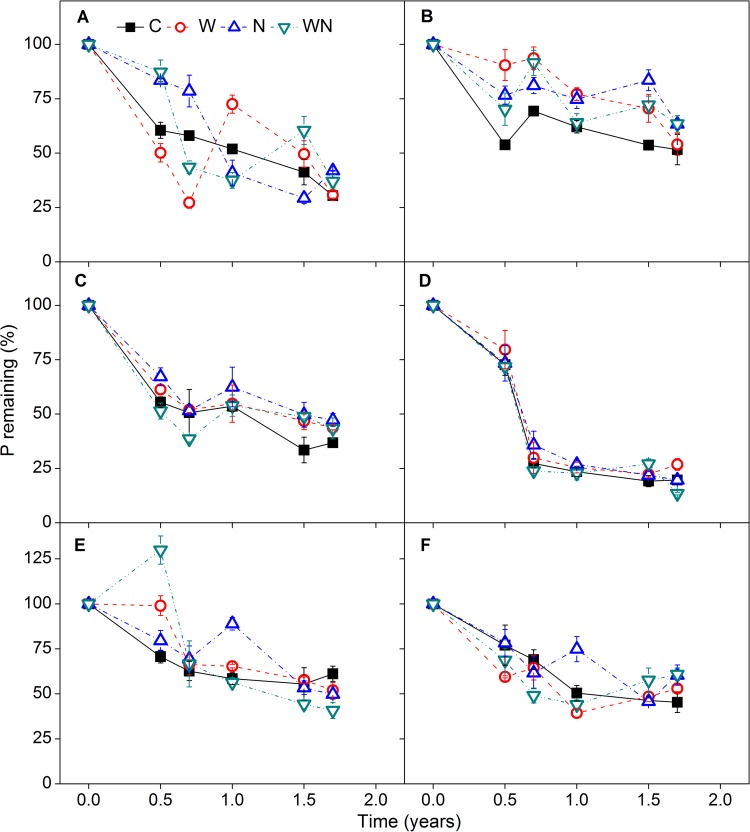
Residual P (as percentage of initial content) of E. oxyrrhynchum (A), S. santolinum (B), S. subcrassa (C), P. communis (D), K. caspia (E), and N. sibirica (F) during the decomposition process under control (C), water (W), nitrogen (N), and water plus nitrogen addition (WN) treatments (experiment I).Vertical bars represent standard errors (n = 3).